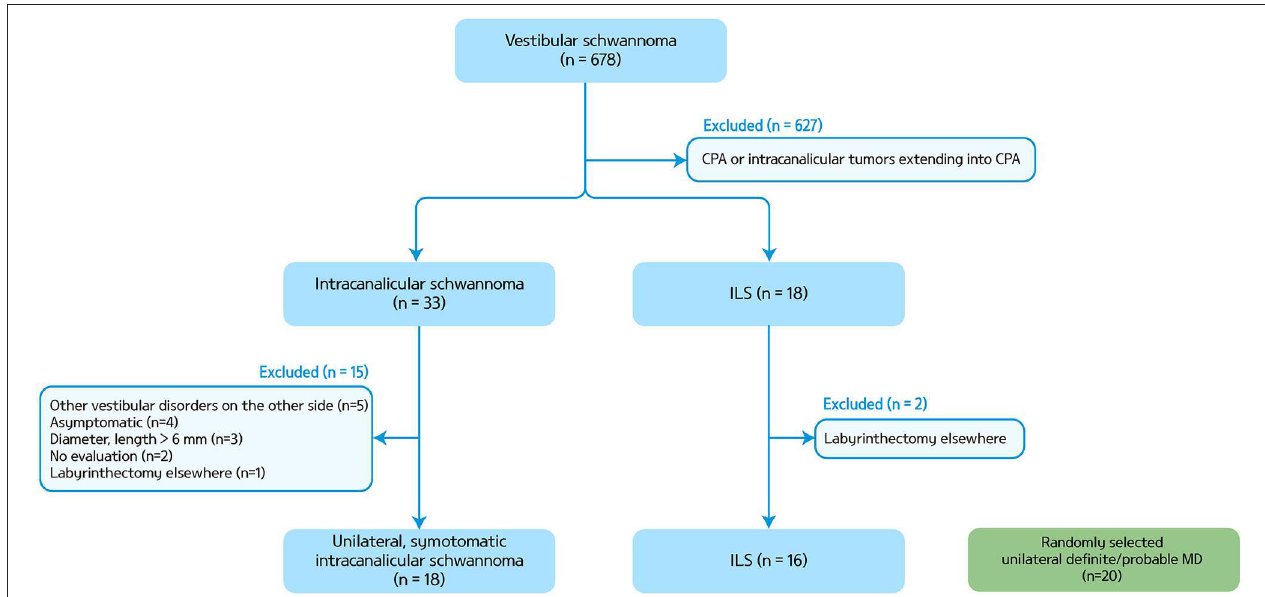
FIGURE 1 | A flow chart for patient selection. CPA, cerebellopontine angle; ILS, intralabyrinthine schwannoma; MD, Meniere’s